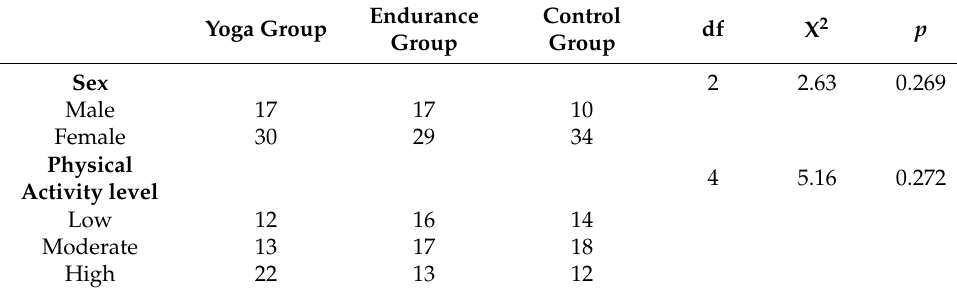
Table 2. Sex and physical activity levels at baseline per group.